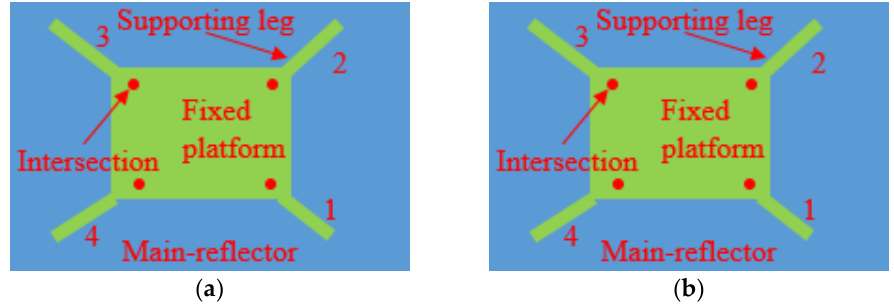
Figure 8. The top view of the fixed platform posture (the observation point is perpendicular to the main reflector): ( a ) The ideal posture; ( b ) The shift posture .